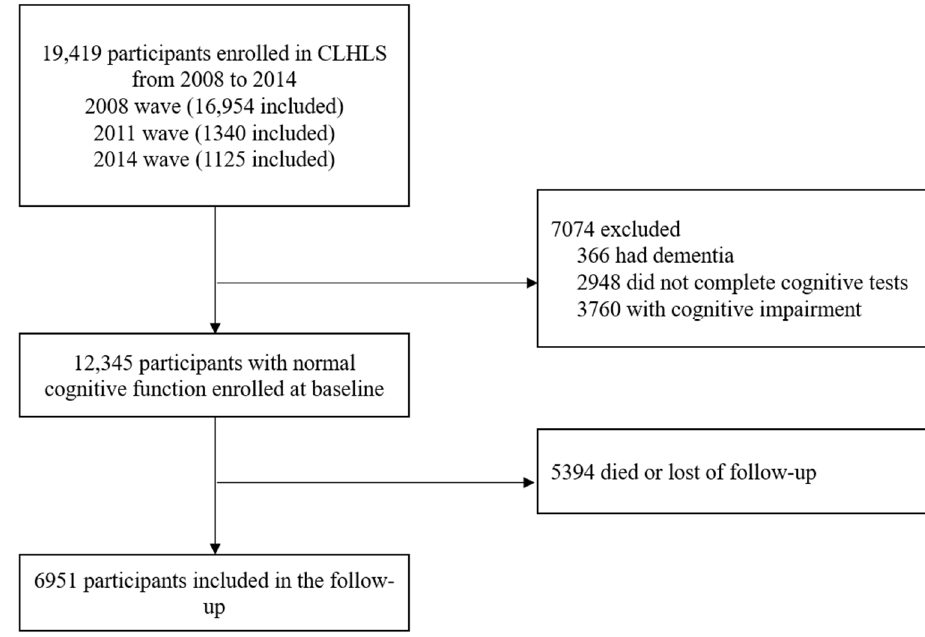
Figure 1. Flow diagram of sample selection.